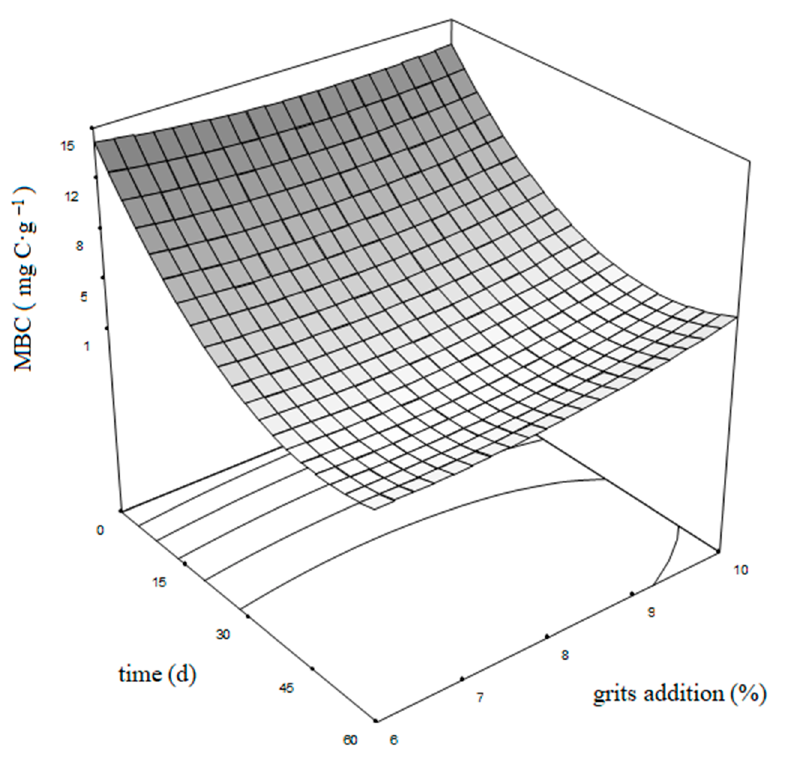
Figure 6. MBC evolution as a function of the composting process time and grits